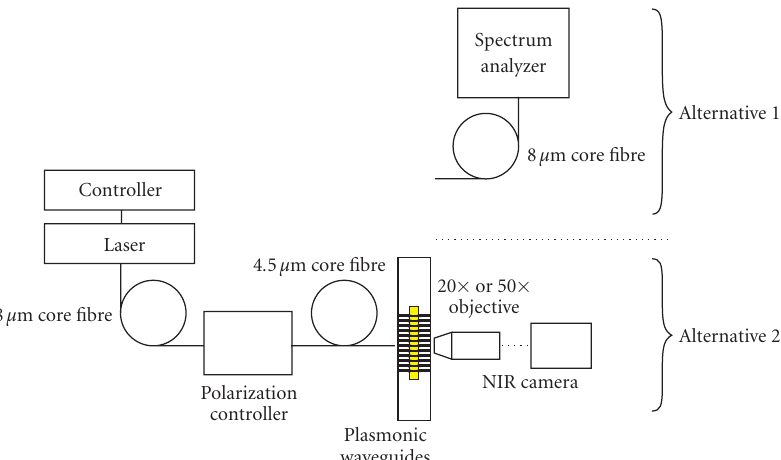
Figure 2: A schema showing the layout of the experimental setup.